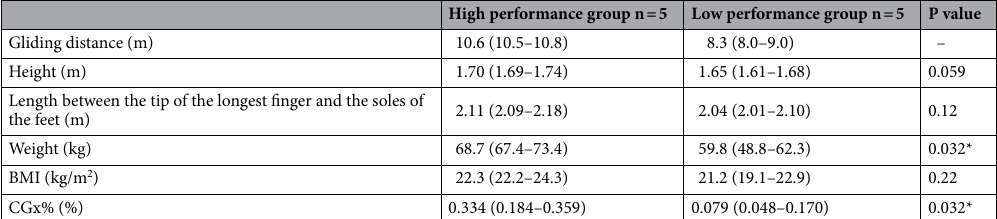
Table 4. Participant characteristics in the measurement of center of gravity. Data are presented as medians with interquartile ranges. CG is the distance from the feet to the participant’s center of gravity. CGx is the movement of CG from the resting position to the streamlined body position. CGx% is the ratio of CGx to the length between the tip of the longest finger and the soles of the feet. *p < 0.05.